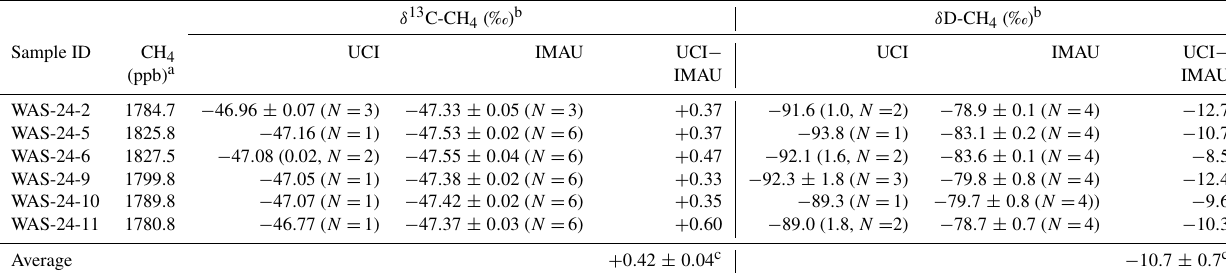
Table 2. Result of intercomparison of δ 13 C-CH 4 and δ D-CH 4 measurements between UCI and IMAU.